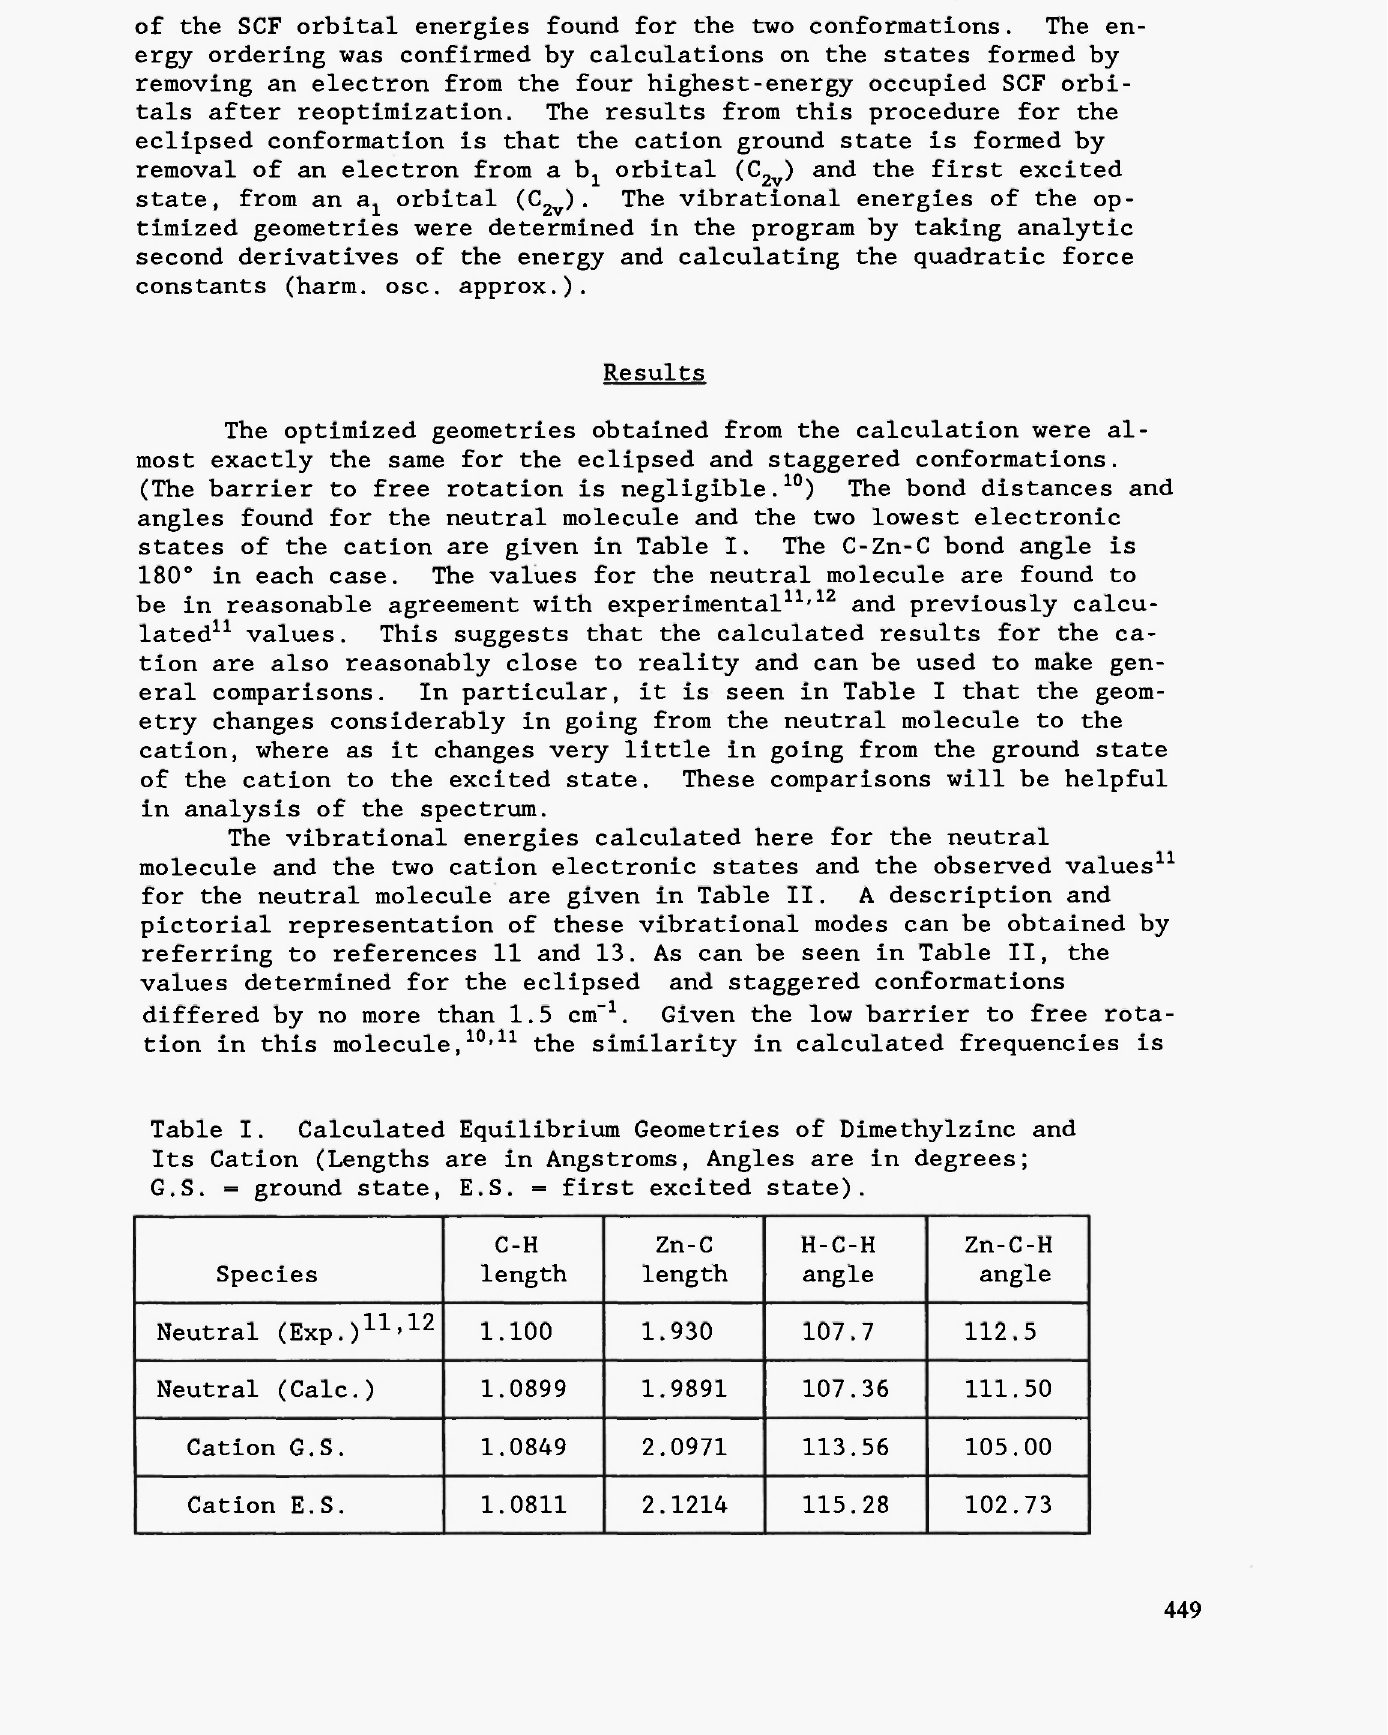
Calculated Equilibrium Geometries of Dimethylzinc and Its Cation (Lengths are in Angstroms, Angles are in degrees; G.S. = ground state, E.S. = first excited